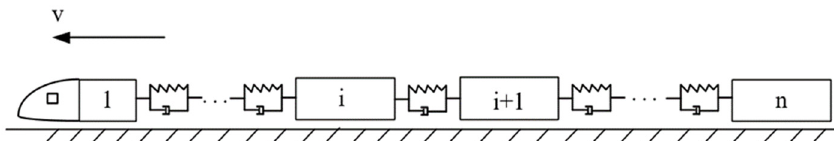
Figure 2. Schematic diagram of the coupling of adjacent sections of a maglev train.